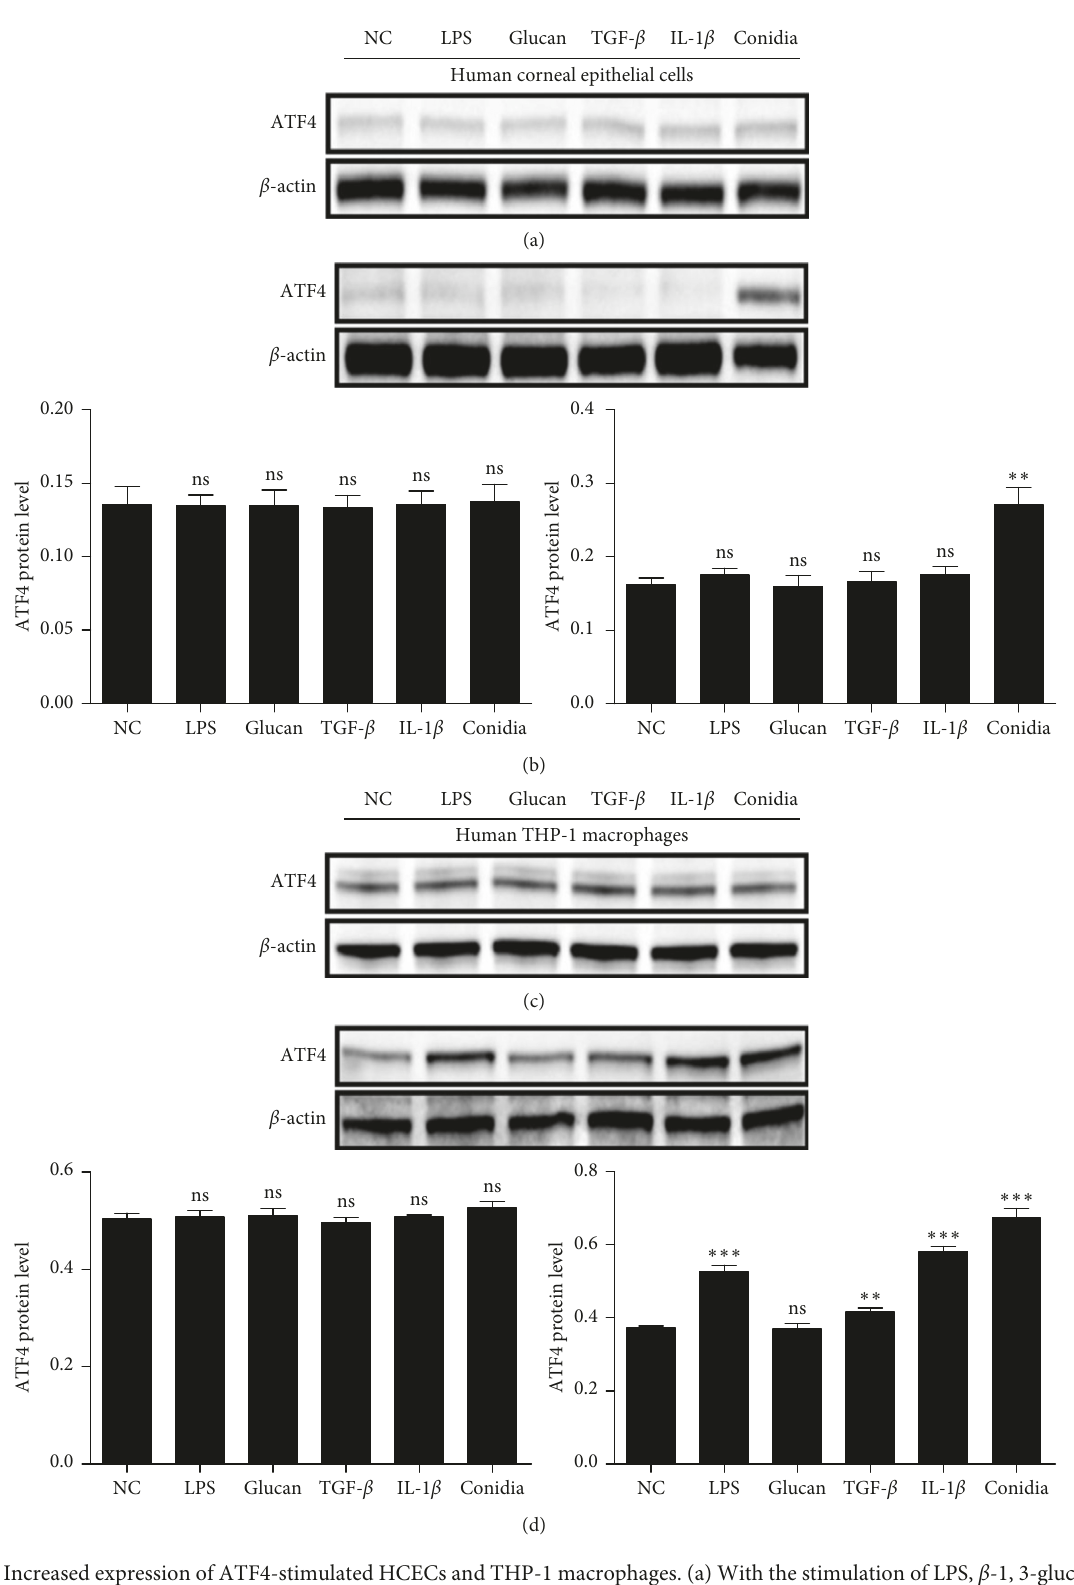
Figure 3: Increased expression of ATF4-stimulated HCECs and THP-1 macrophages. (a) With the stimulation of LPS, β -1, 3-glucan, TGF- β , IL-1 β , and A. fumigatus conidia, ATF4 protein levels in HCECs were not changed significantly at 8 hours. (b) ATF4 protein levels in HCECs did not change significantly at 16 hours with the stimulation of LPS, β -1, 3-glucan, TGF- β , and IL-1 β , but significantly increased with A. fumigatus conidia. (c) With the stimulation of LPS, β -1, 3-glucan, TGF- β , IL-1 β , and A. fumigatus conidia, ATF4 protein levels in THP-1 macrophages did not change significantly at 8 hours. (d) ATF4 protein levels in HCECs were higher after stimulation with LPS, TGF- β , IL-1 β , and A. fumigatus conidia at 16 hours, but did not change significantly with β -1, 3-glucan. The mean values and standard deviations of two independent experiments are shown; ∗∗ P < 0 . 01, ∗∗∗ P < 0 .